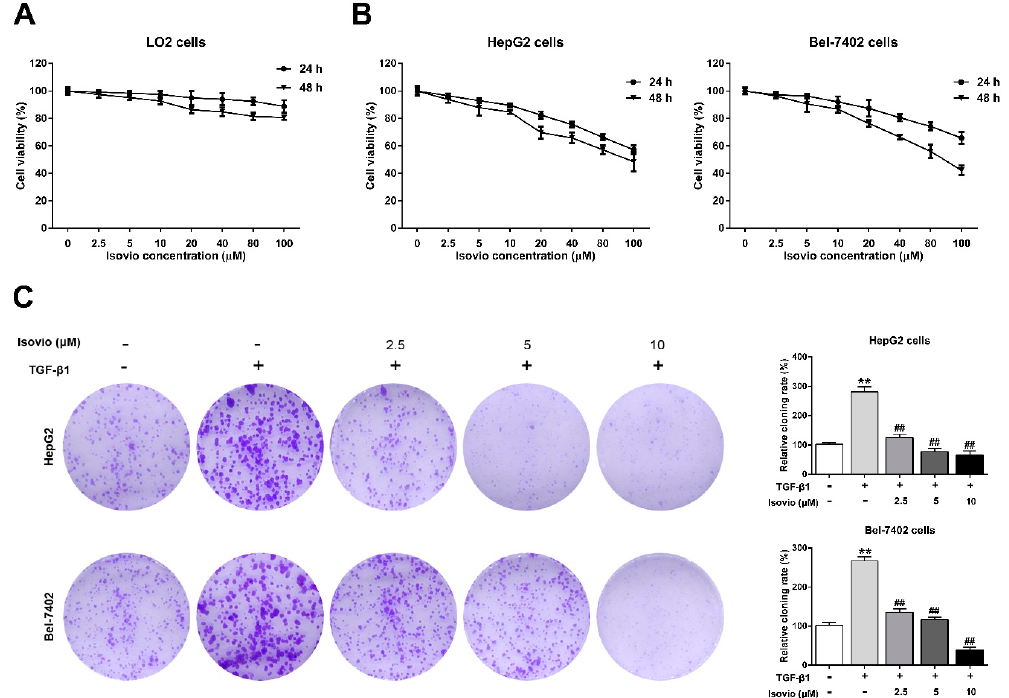
Figure 2. Effects of isoviolanthin (isovio) on the viability of hepatocellular carcinoma (HCC) and human LO2 normal liver cells and on the clonogenic potential of HCC cells. ( A ) The cell viability of LO2; ( B ) HepG2, and Bel-7402 cells treated with isoviolanthin (2.5 µ M, 5 µ M, 10 µ M, 20 µ M, 40 µ M, 80 µ M, and 100 µ M) for 24 h and 48 h was determined by MTT [3-(4,5-dimethythiazol-2-yl)-2,5-diphenyl tetrazolium bromide] assay; ( C ) HepG2 and Bel-7402 cells were incubated with 10 ng/mL transforming growth factor (TGF)- β 1 and isoviolanthin (2.5 µ M, 5 µ M, and 10 µ M) for two weeks, and the clonogenic (mean ± SD) are shown, n = 3. ** p < 0.01 versus the control group; ## p < 0.01 versus the TGF- β 1